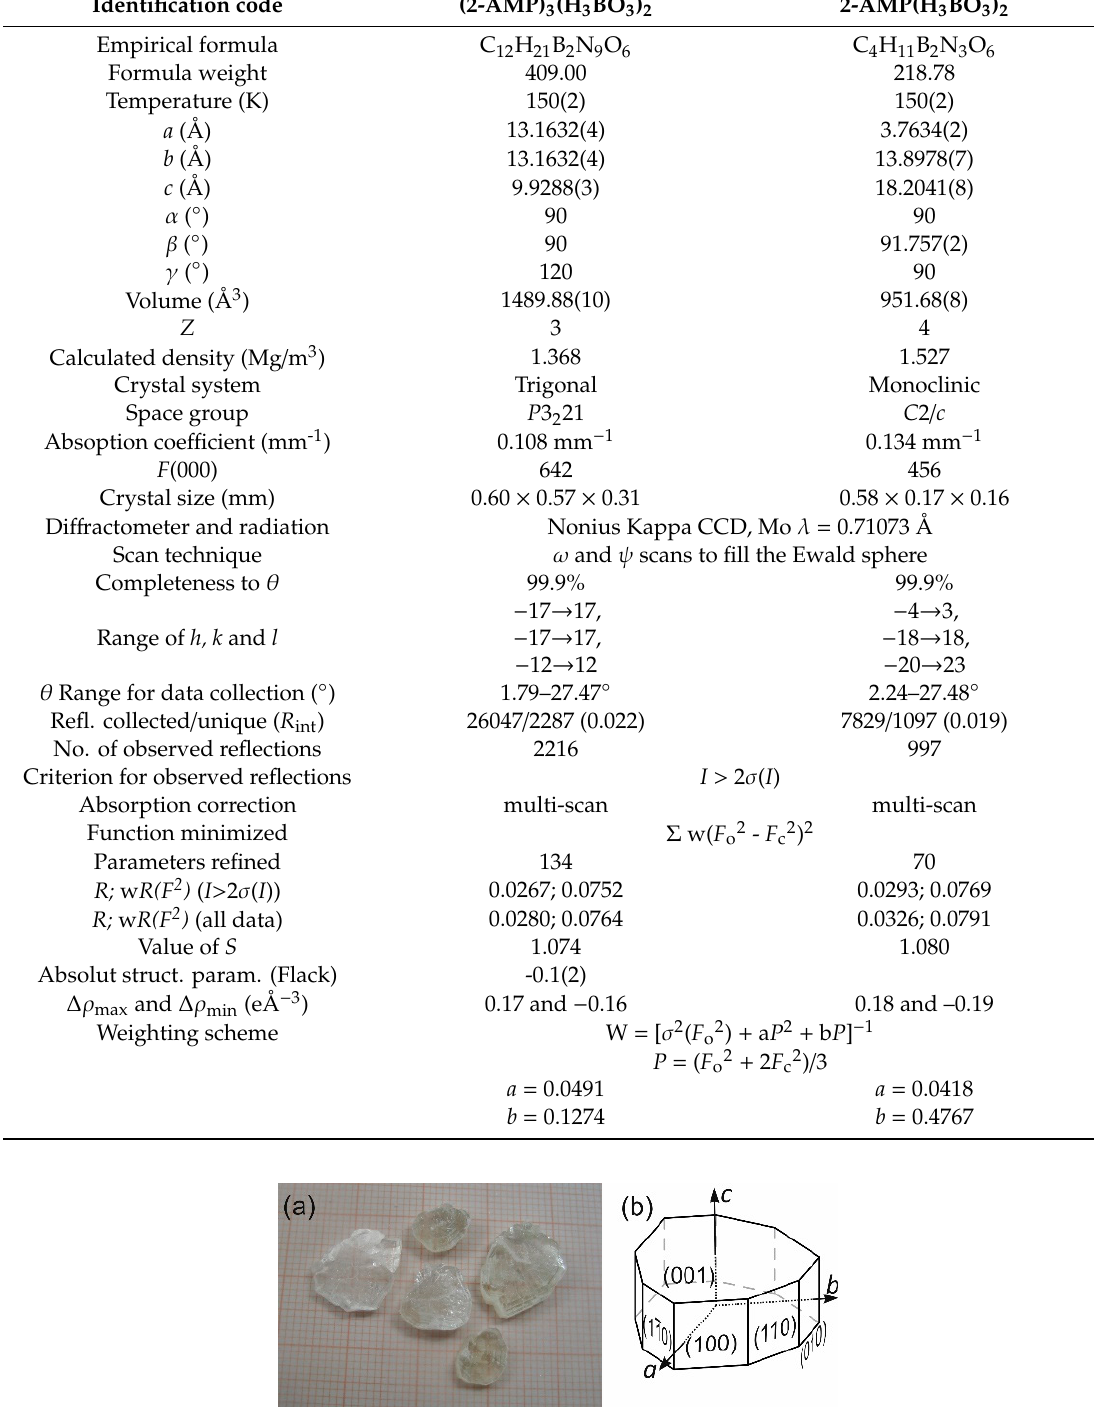
Table 1. Crystal data and structure refinement details of the studied cocrystals.